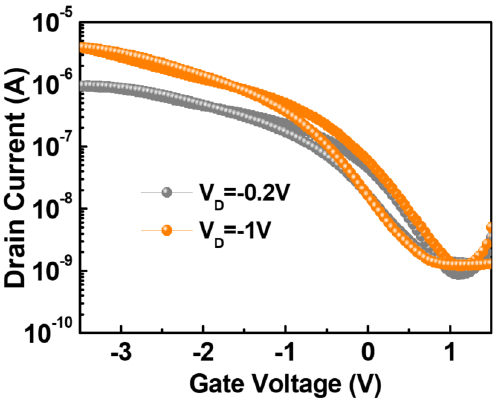
Figure 5. Transfer I D -V G curves of a p-type SnO TFT under both forward and reverse sweep modes.